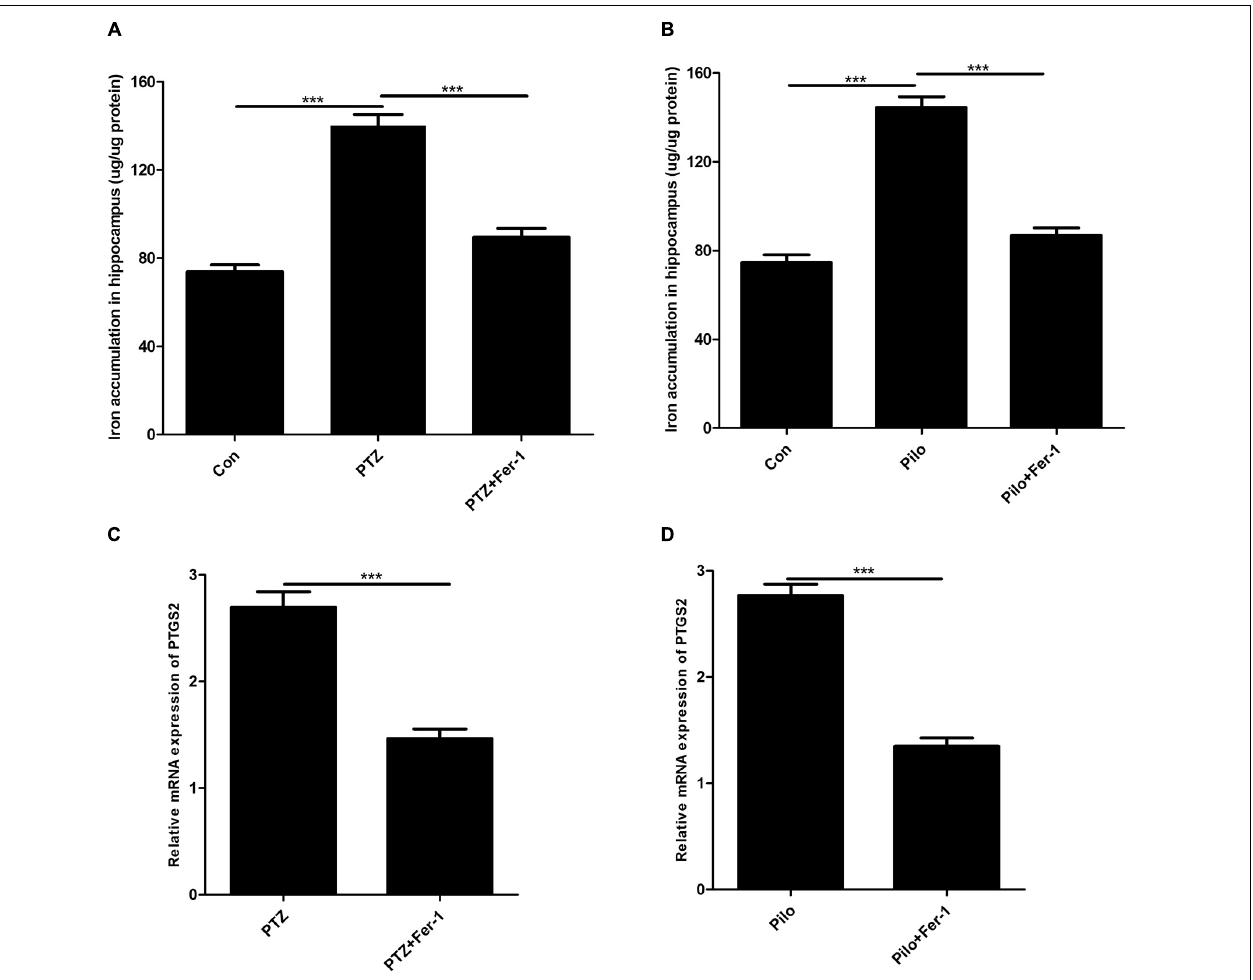
FIGURE 3 | Fer-1 decreases iron accumulation and PTGS2 mRNA in the hippocampus of PTZ- and Pilo-treated mice. (A , B) Quantitative analysis of iron content in the hippocampus of PTZ- and Pilo-treated mice ( ∗∗∗ p < 0.001, n = 6). (C , D) Effect of PTGS2 mRNA in the hippocampus of PTZ kindling and Pilo-induced seizure models after Fer-1 treatment. In the Pilo-matched control group, diazepam treatment alone did not cause iron accumulation and PTGS2